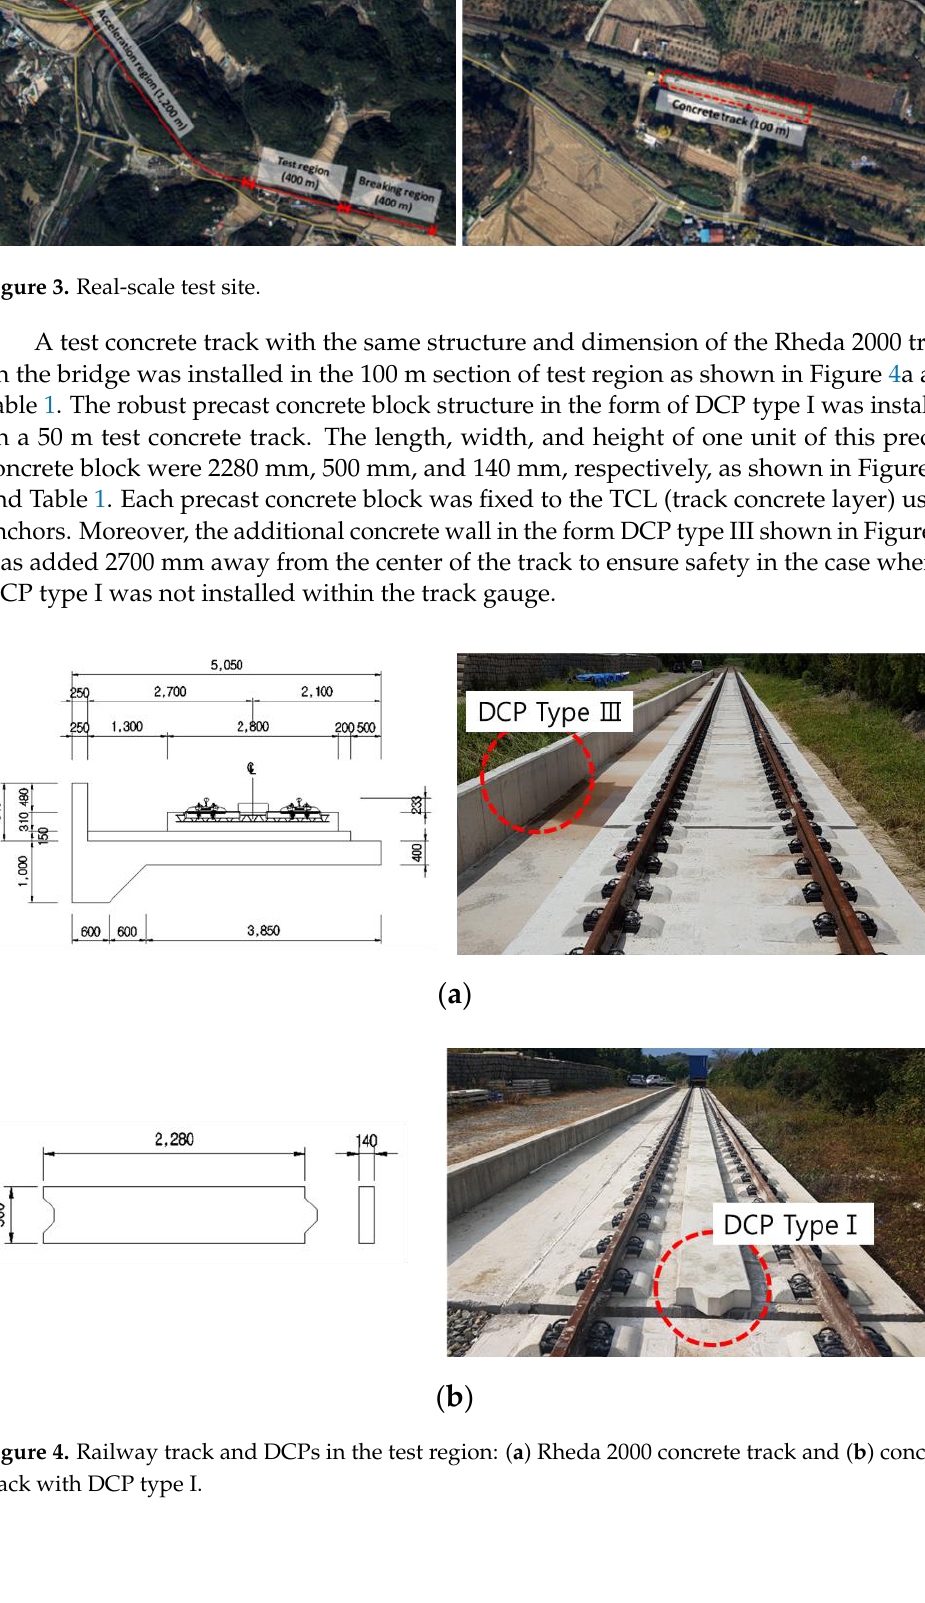
Figure 3. Real-scale test site.